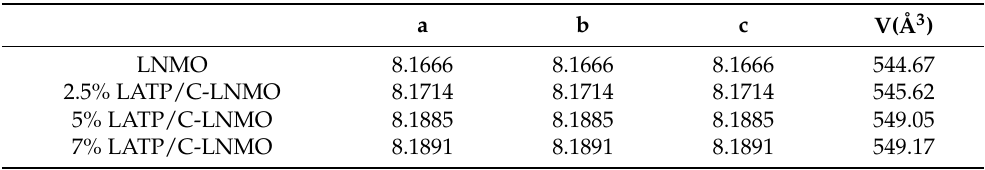
Table 1. Unit cell data of bare LNMO and LATP/C-LNMO.